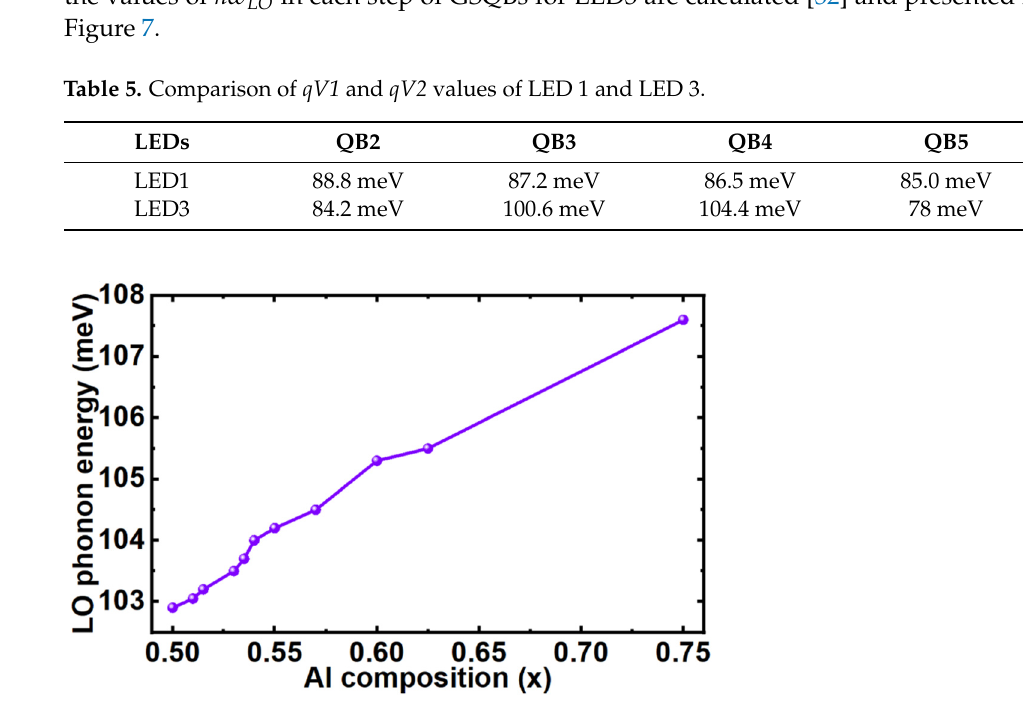
Figure 7. Calculated longitudinal optical (LO) phonon energy in Al x Ga 1 − x N layer. Table 5. Comparison of qV1 and qV2 values of LED 1 and LED 3.